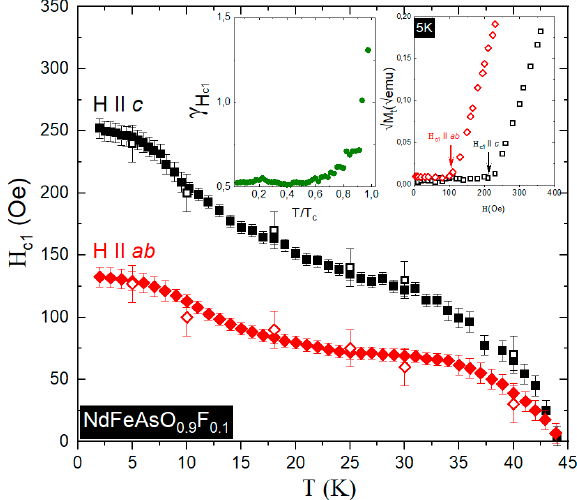
Figure 5. The extracted lower critical field, H c1 , of NdFeAsO 0.9 F 0.1 as a function of temperature. The data were collected for both orientations for H || ab and H || c . The bars show the uncertainty of estimation by the deviating point of the M-H [11]. The inset shows the temperature dependence of the anisotropy of H c1 : γ Hc1 = H c1||c / H c1||ab .